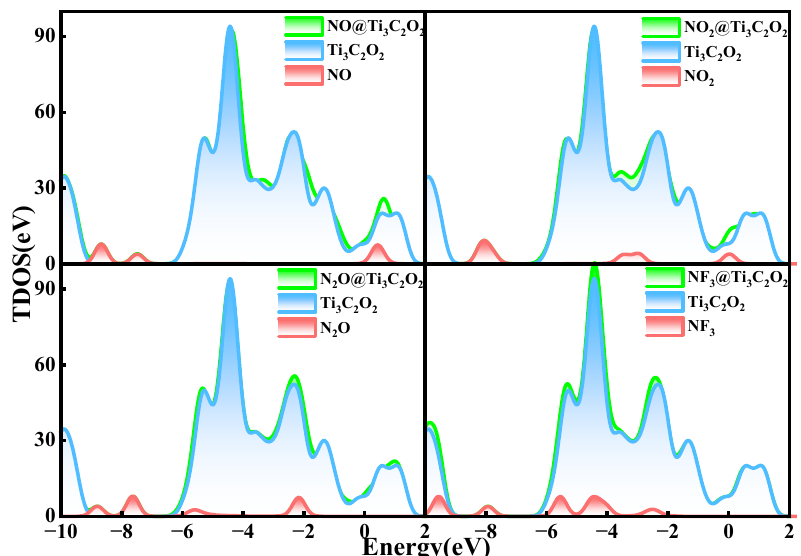
Figure 6. Total electron density of states of Ti 3 C 2 O 2 adsorbing NO, NO 2 , N 2 O, and NF 3 .